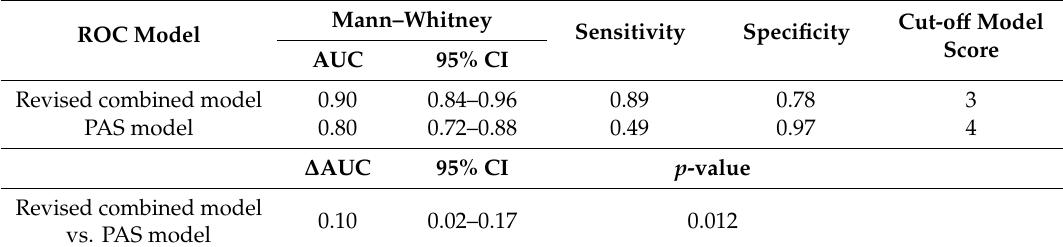
Table 5. Revised combined model and pediatric appendicitis score (PAS). ROC model associated with PAS model.